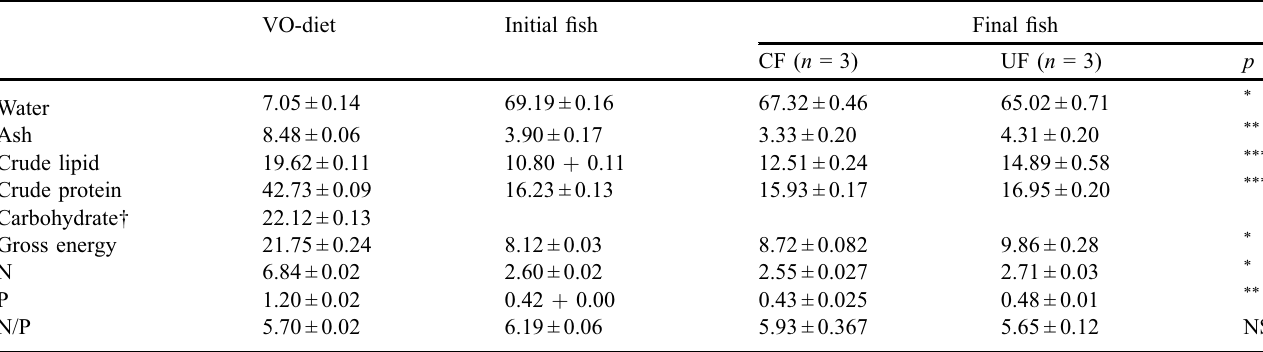
Table 6. Proximate composition (%w.w.), gross energy (kJ g (cid:1) 1 ), N, P (% w.w.) and N/P of sea bass at the beginning (initial) and after 12 weeks of rearing ( fi nal) in CF ( fi sh group in control-RAS) and UF ( fi sh group in Ulva -RAS).